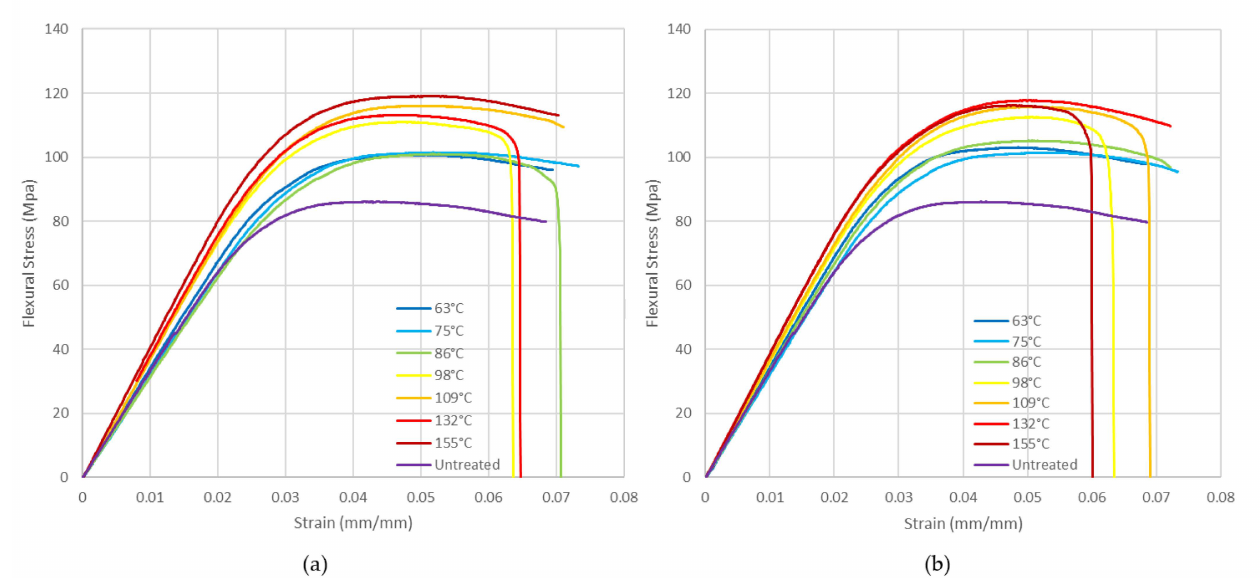
Figure 17. ABS flexural stress vs. strain at different annealing temperatures: ( a ) with mould; ( b ) without mould.